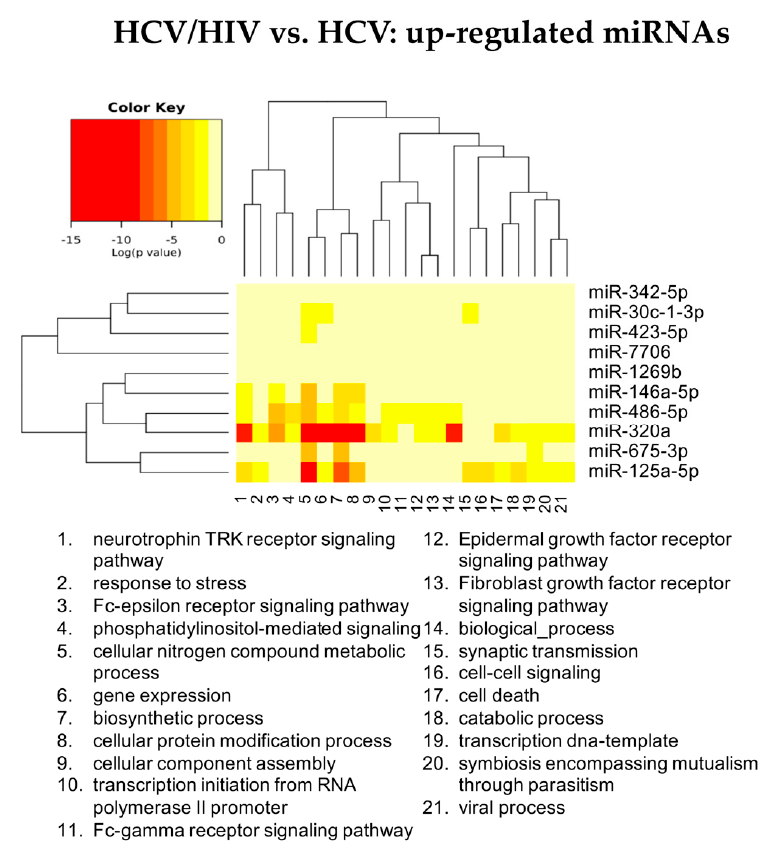
Figure 8. Heatmap showing the significance (see color key) of the association of up-regulated miRNAs with “Gene Ontology-Biological Process” categories, as identified applying the “Categories Union” method.